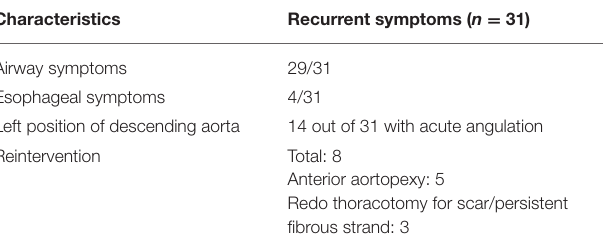
TABLE 1 | Baseline characteristics.